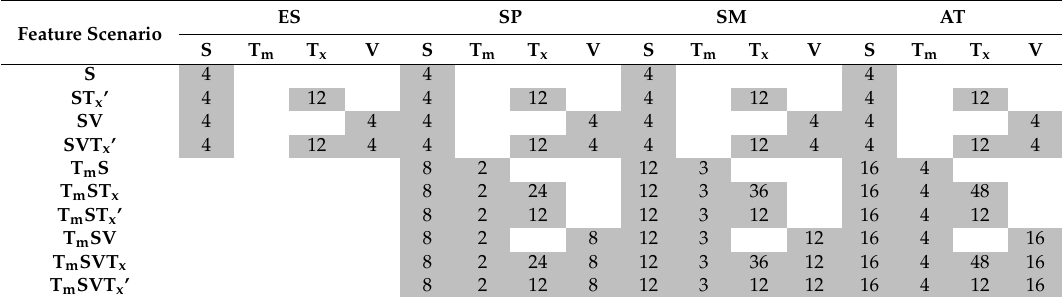
Table 3. Groups of input variables for in-season crop classification. Numbers in dark color means the group is included in the